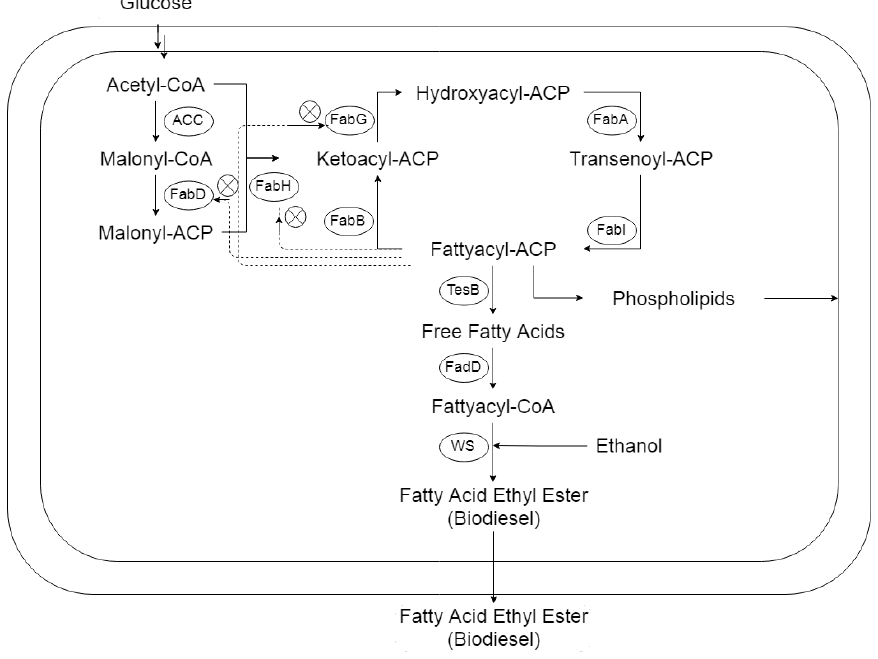
Figure 1. The fatty acid ethyl ester (FAEE) biosynthesis in bacteria. The metabolic pathway of fatty acid synthesis and biodiesel is shown. Enzymes ACC: Acetyl-CoA-carboxylase. FabD: Malonyl-CoA-Synthase. FabH: Malonyl-CoA-ACP-synthase, FabG: Hydroxyacyl-ACP-synthase. FabA: Enoyl-ACP-synthase. FabI: Acyl-ACP-synthase. TesB: Thioesterase. FadD: fatty-acyl-CoA-ligase. WS: wax synthase are shown. The dotted lines represent feedback